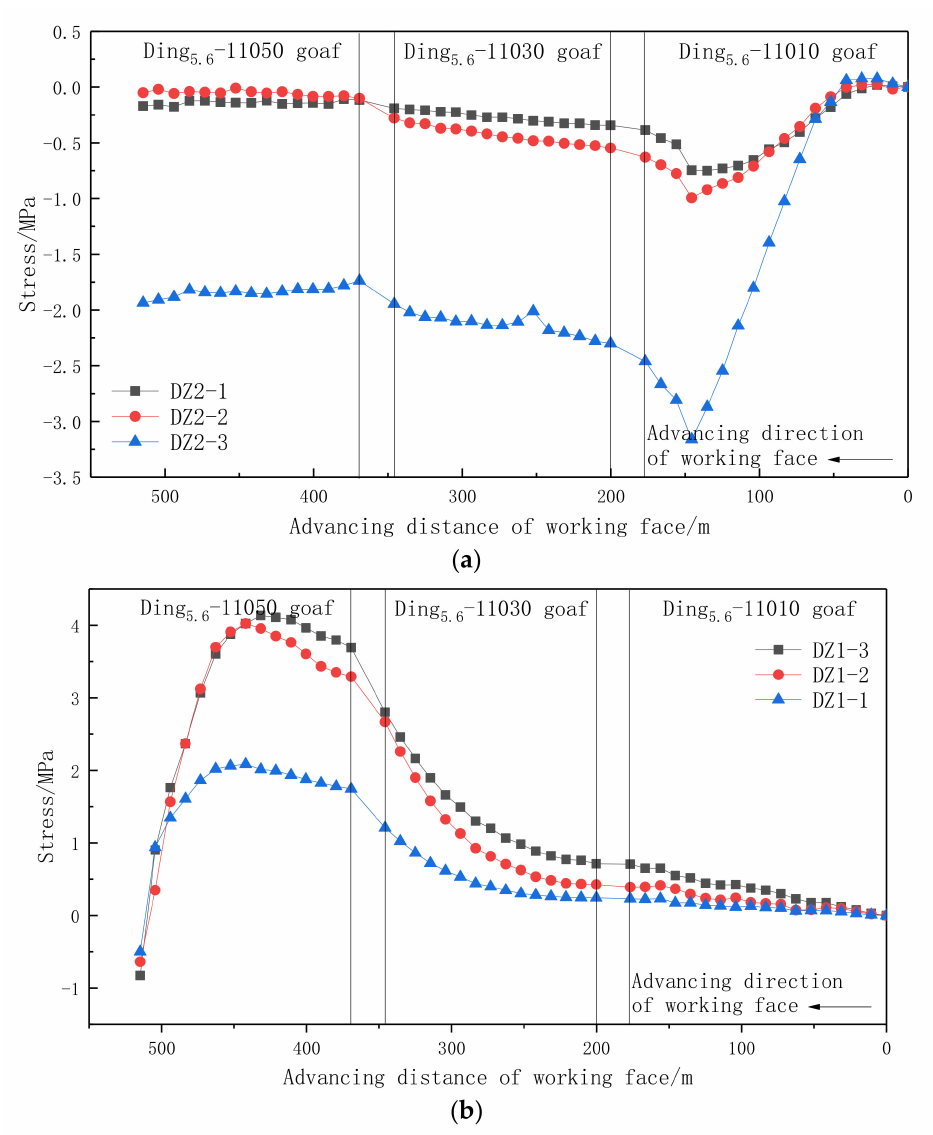
Figure 12. Evolution diagram of pressure-relief angular stress in coal seam of Group E: ( a ) Pressure- relief angle of the upper slope of Group E coal seam; and ( b ) Pressure-relief angle of the lower slope of Group E coal